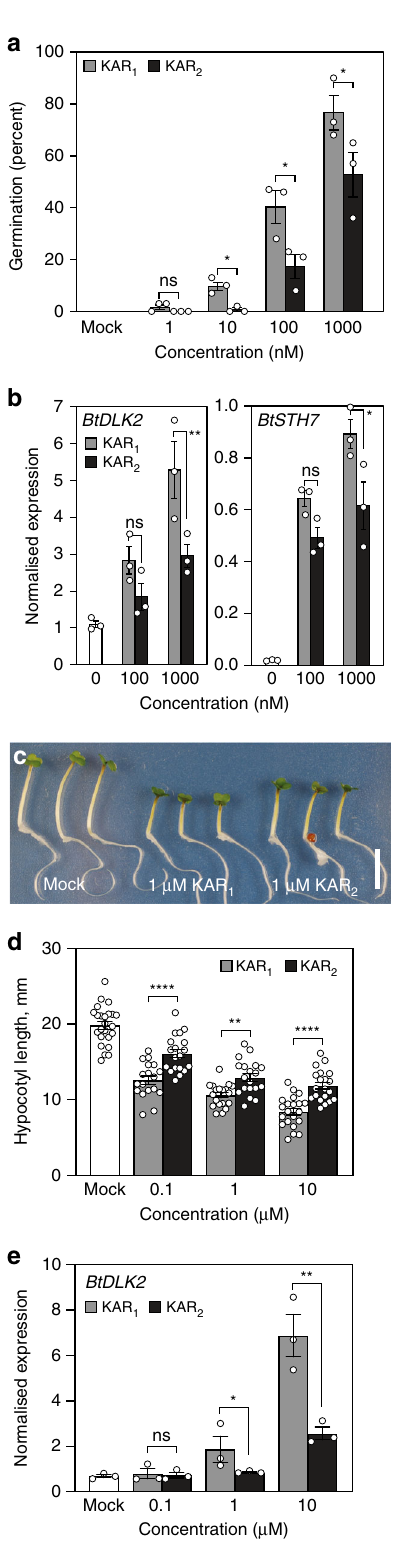
expression pro fi le of KAI2 in Arabidopsis . Such fusions of GFP with KAI2 proteins have been used previously to analyse KAI2 activity 19,40,41 . Both BtKAI2a and BtKAI2b complemented the seedling and leaf phenotypes of kai2-2 , whereas BtKAI2c did not (Fig. 2c, d). GFP-BtKAI2a and GFP-BtKAI2b accumulated at consistent levels when detected using both an anti-KAI2